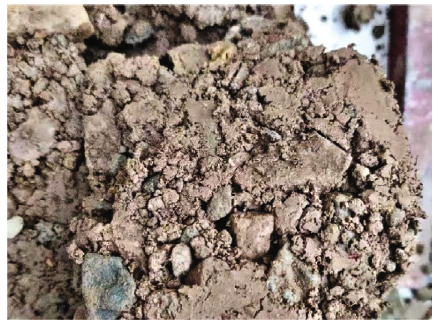
Figure 10: “ Cavitation ” in fi ller after water